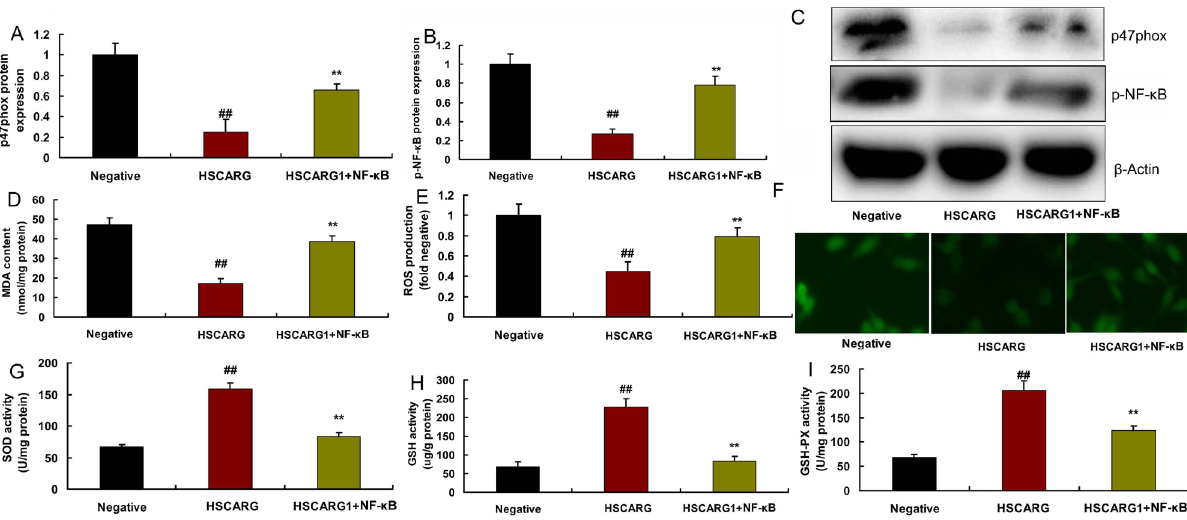
Fig. 6 - The overexpression of nuclear factor kappa B (NF-κB) activity in the effects of HSCARG in coronary heart disease. 47phox/NF-κB protein expressions (A, B, and C), malondialdehyde (MDA) and reactive oxygen species (ROS) production levels (D, E, and F), superoxide dismutase (SOD), glutathione (GSH), and glutathione peroxidase (GSH-PX) levels (G, H, and I). Negative=negative mimic group; HSCARG=overexpression of HSCARG group; HSCARG+NF-κB=overexpression of HSCARG and NF-κB group. ##P<0.01 compared with negative mimic group; **P<0.01 compared with overexpression of HSCARG